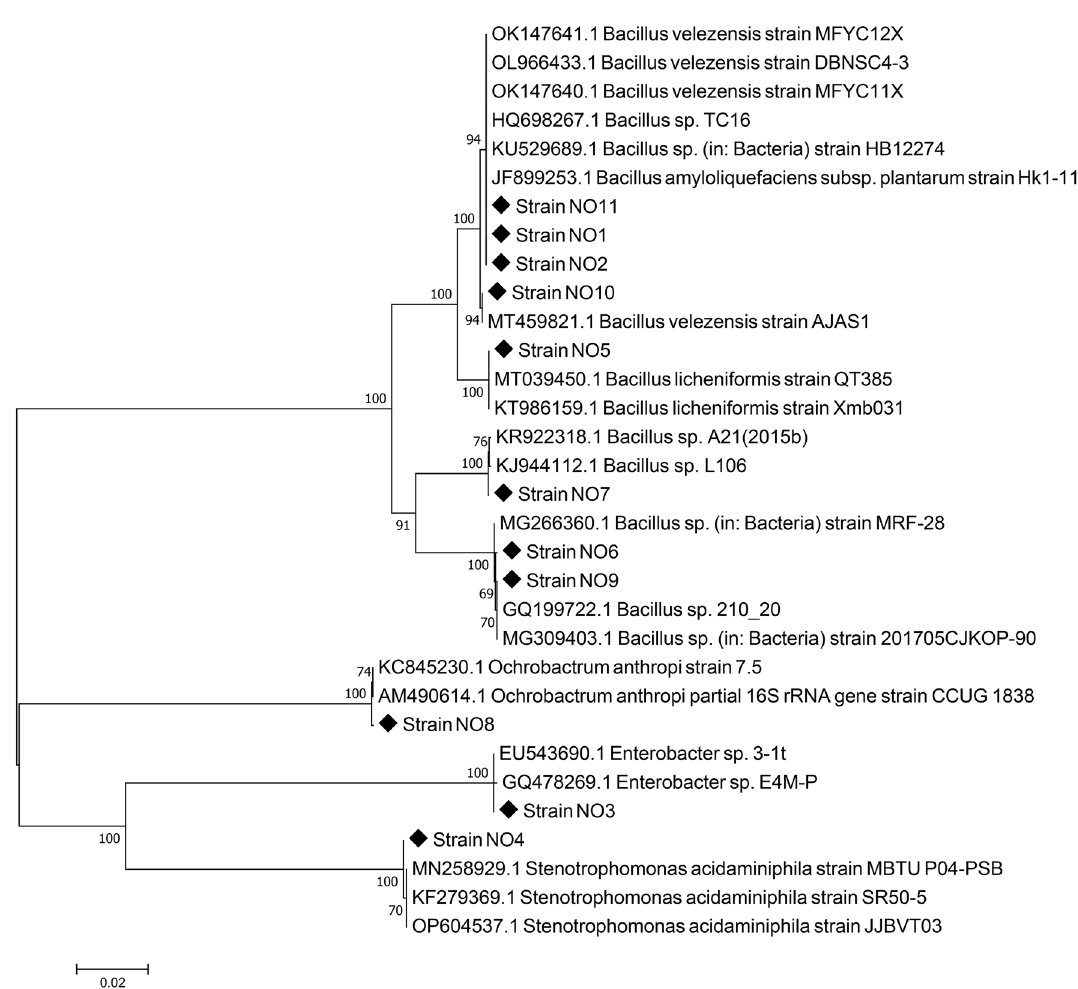
Figure 3. Neighbor-joining phylogenetic tree showing the position of eleven isolated PAs. Numbers at nodes indicate percentage levels of bootstrap support based on a neighbor-joining analysis of 1000 resampled datasets. The scale bar indicates 0.01 substitutions per nucleotide